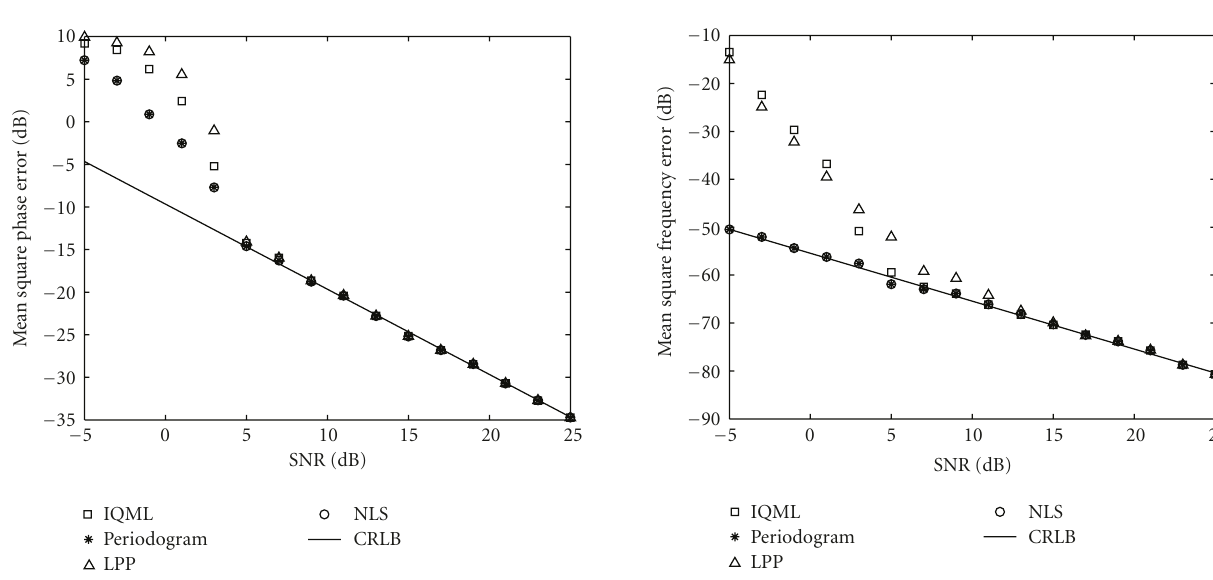
Figure 5: MSE for ω of single complex sinusoid at N = 128.